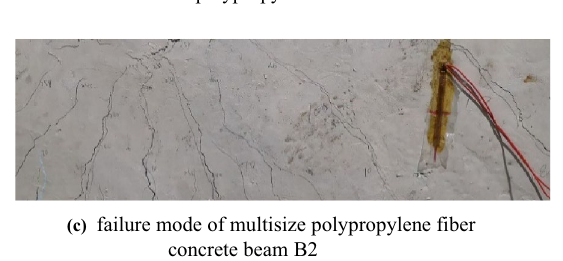
Fig. 8 Failure modes of test beams in each